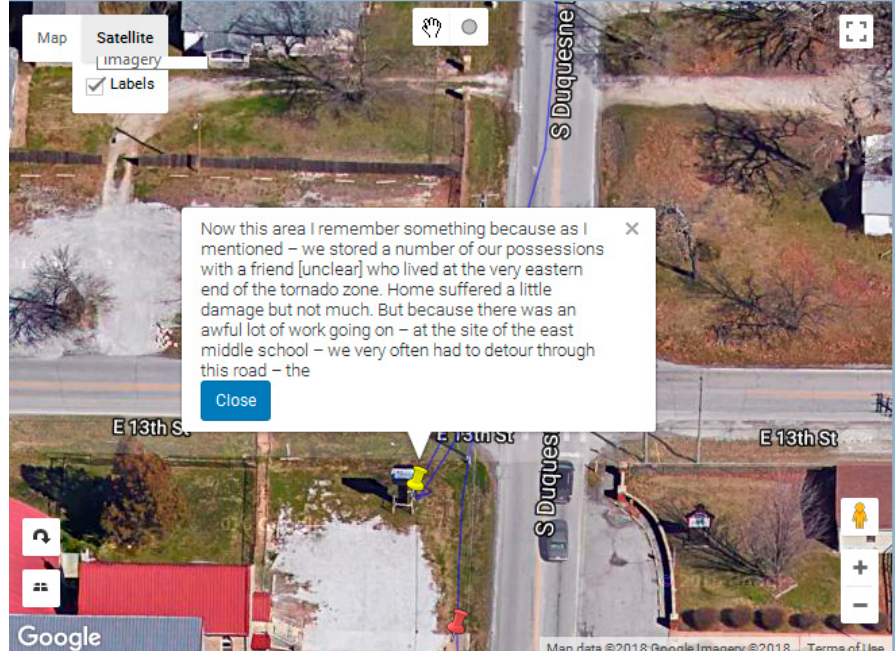
Figure 10. Narrative text for matching keyword ‘damage’ and category ‘Fuzzy space’. The text box